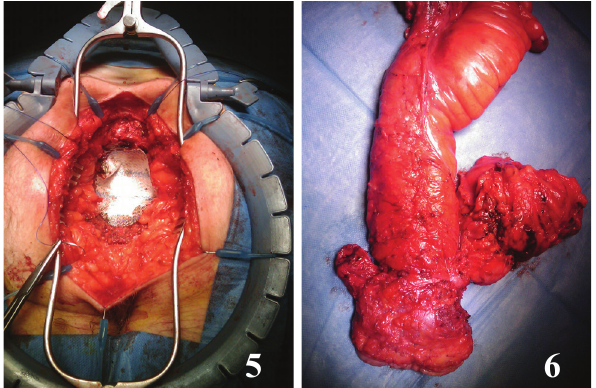
Figure 5. Perineal defect being closed with a mesh Figure 6. Specimen in situ contains coccyx posteriorly, urinary bladder and prostate in front.